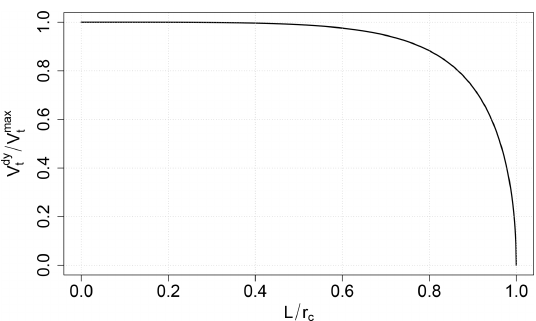
Figure 11. Dimensionless relationship between the ratio of the minimum (dent) tangential velocity and the maximum tangential velocity vs. half the peak-to-peak distance ( L ) in percentage of r c .